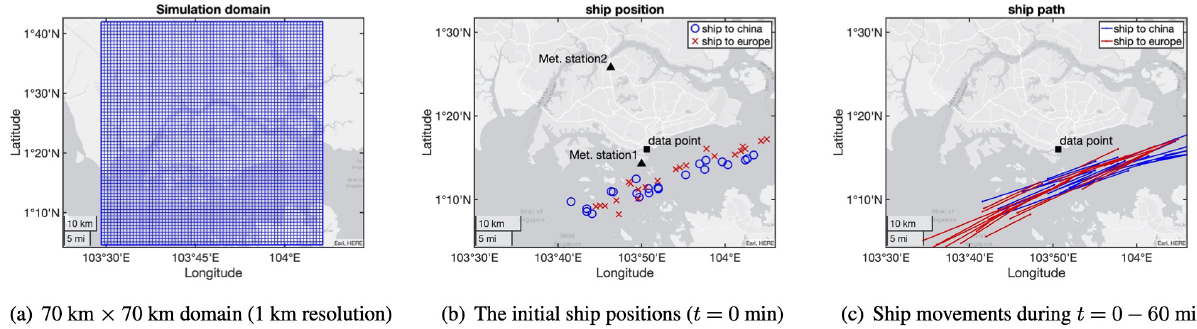
Figure 3. Configuration of the simulation domain in Singapore used in the simplified simulation. Ships to China are indicated by blue circles, and ships to Europe are indicated by red crosses; lines denote ship routes. Table 2. Meteorological inputs applied in MCWIND pre-processing utility for the simplified simulation.